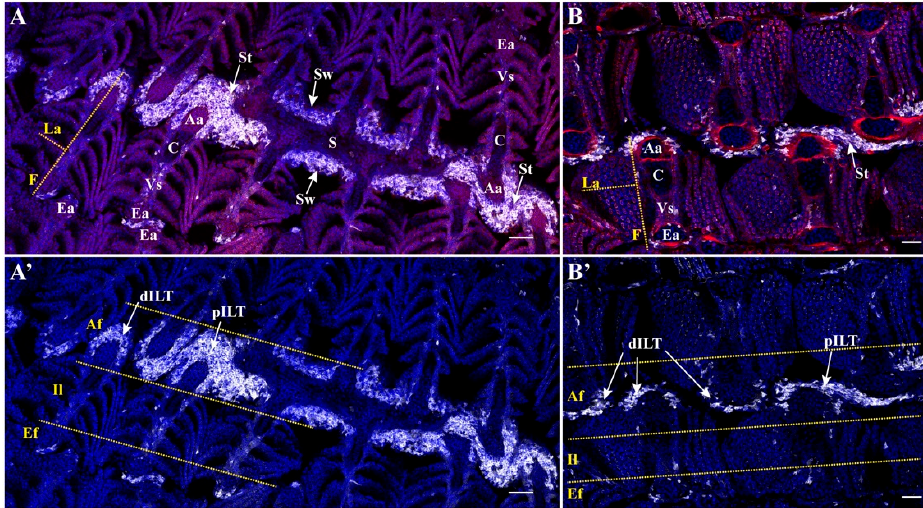
Figure 6. Gill-associated lymphoid tissues (GIALT) of zebrafish ( D. rerio ). Spinning disk confocal deconvolved images of adult zebrafish gills coronal sections across and above the interbranchial septum ( A , B’ ). ( A , B’ ) represent 10 μ m maximum intensity projection (MIP) from a multifields stitch (20× objective) displaying phalloidin/DAPI/zap70 labeling for ( A , B ) and DAPI/zap70 labeling for ( A’ , B’ ). Images were acquired from 30 μ m thick whole-organism cryosections, while tissues structures are highlighted with phalloidin (F-actin, red) and DAPI (Nuclei, blue) stainings in order to examine the distribution of Zap-70+ cells (white). ( A , A’ ). Zap-70+ cells are mainly concentrated within the afferent aspect of the filaments. Note the high number of Zap-70+ cells within the septum wall, which then assemble into the proximal ILT (pILT) at the uppermost layer of the interbranchial septum. ( B , B’ ). Zap-70+ cells then extend upward from the top of the interbranchial septum to form the distal ILT (dILT) along the afferent aspect of filaments. In addition to the structured lymphoid tissue observed, Zap-70+ cells are also distributed in a diffuse manner among the interlamellar region and the efferent aspect of filaments ( A’ , B’ ). F, Filament; La, Lamellae; S, Septum; St, Septum top; Sw, Septum wall; Af, Afferent aspect; Il, interlamellar region; Ef, Efferent aspect; Aa, Afferent artery; Vs, Venous sinus; Ea, Efferent artery; C, Cartilage. Scale bar: 50 μ m ( A , A’ ) and 30 μ m ( B , B’ ).